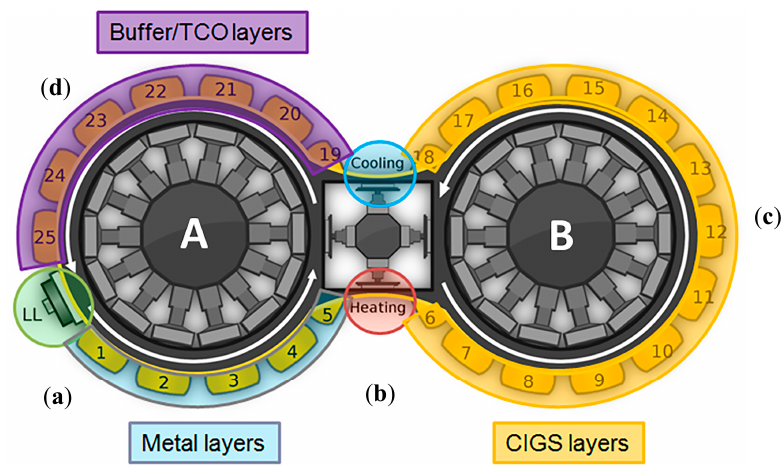
Figure 12. The schematic process sequence of the load-lock DUO solar cell manufacturing system of Midsummer ® , ( a ) stations 1 to 5, ( b ) heating station, ( c ) stations 6 to 18 and ( d ) stations 19 to 25. Reproduced from [102] with permission. Copyright 2017 Elsevier.